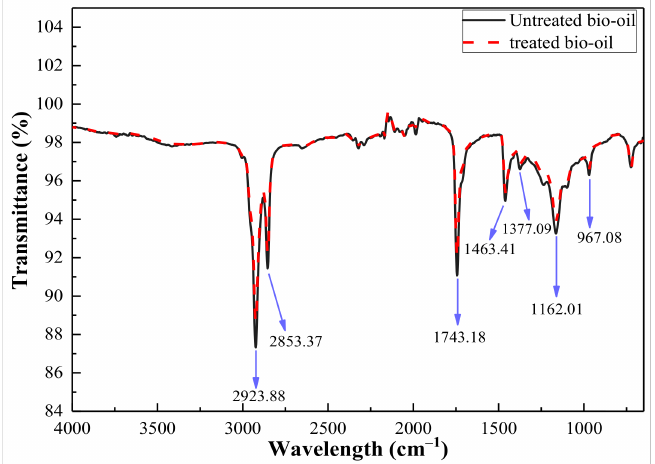
Figure 16. Infrared spectroscopy of untreated and treated